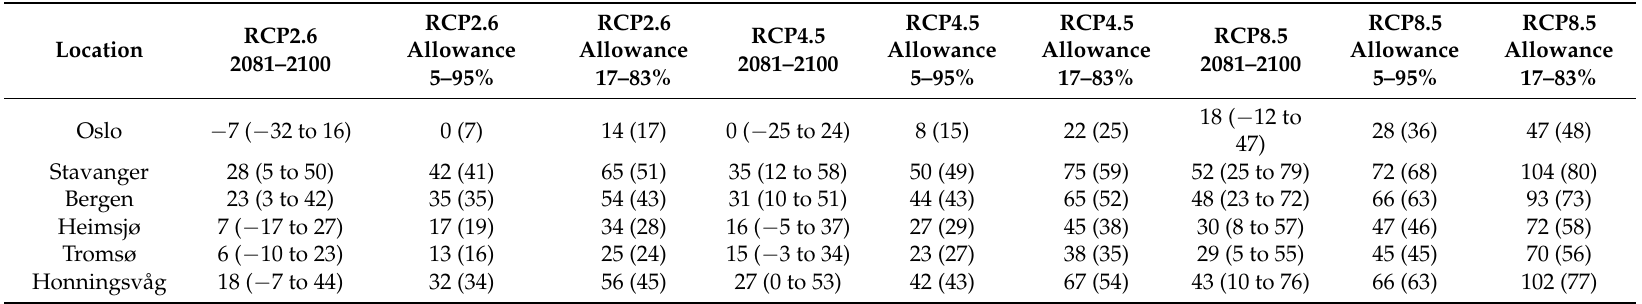
Table 4. Allowances (in cm) calculated for six key locations using the 200-year return heights and projected ensemble mean RSL change over the period 1986–2005 to 2081–2100 (the 5% to 95% ensemble spread is given in parentheses). Allowances are given for two different choices of the level of likelihood assigned to the ensemble spread. The parentheses next to the allowances give the value of the standard error above the ensemble mean projected RSL.